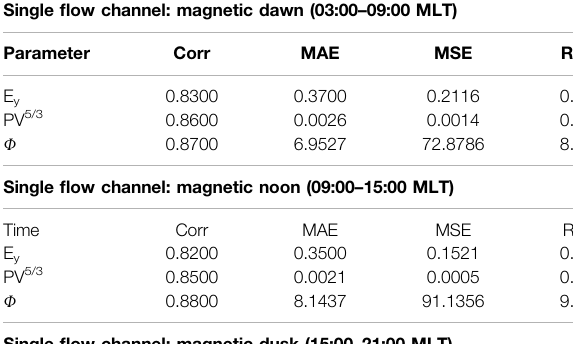
TABLE 2 | Error Analysis for Single Flow Channel.